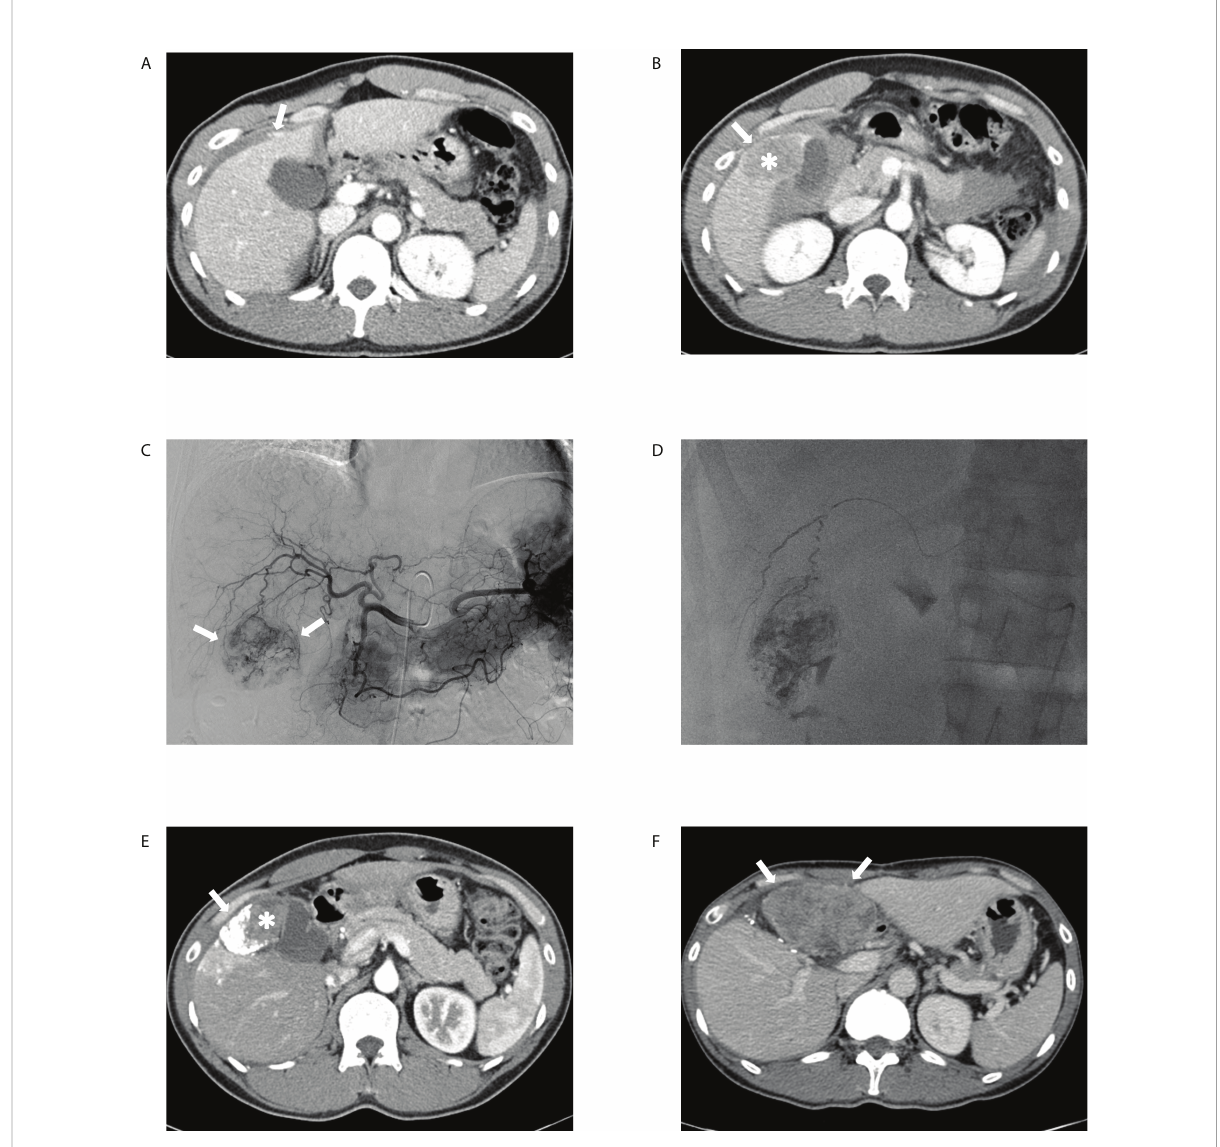
FIGURE 5 Transcatheter arterial chemoembolization (TACE) performed for ruptured hepatocellular carcinoma in a 41-year-old male patient. The portal phase of the initial computed tomography (CT) demonstrates (A) contrast media extravasation (arrow) from the tumor to the peritoneum and (B) washout lesion (asterisk) in segment 6 of the liver protruding to the peritoneum with focal discontinuity (arrow) of the liver surface, suggesting ruptured hepatocellular carcinoma. (C) Celiac angiography showing hypervascular tumor staining (arrows) corresponding to the CT fi ndings. (D) Spot image of fl uoroscopy demonstrating administration of iodized oil-doxorubicin mixture at the branch of S6 with partial uptake within the tumor. (E) Portal phase of the 1-month follow-up CT shows lipiodol-doxorubicin uptake (arrow) in the lateral aspect of the index tumor with a residual lesion (asterisk) in the medial portion. (F) Portal phase of the 11-month follow-up CT after tumorectomy performed at 6- month demonstrates a huge hypoattenuating mass (arrows) in the peritoneum, suggesting intraperitoneal drop